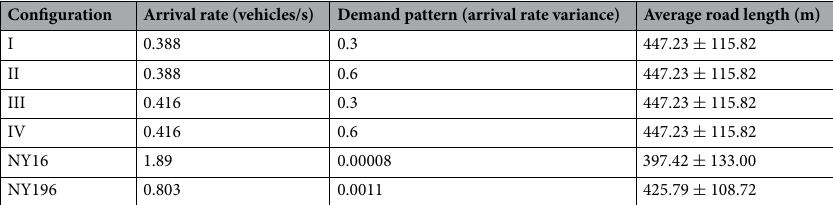
Table 1. Traffic flows and road lengths assumed in the simulation scenarios.